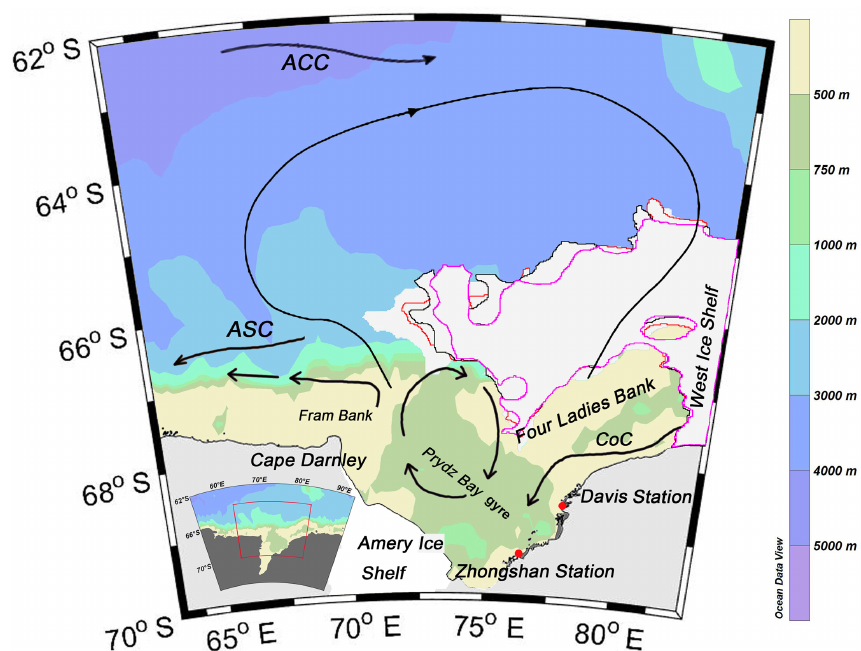
Figure 1. Ocean circulations in Prydz Bay derived from Roden et al. (2013), Sun et al. (2013) and Wu et al. (2017). ASC is the Antarctic Slope Current, CoC is the Antarctic Coastal Current and ACC is the Antarctic Circumpolar Current. During the 4-week cruise, the sea-ice extent varied as indicated by the contoured white areas: the pink line represents week 1 (2–9 February 2015), the black line represents week 2 (10–17 February 2015), the red line represents week 3 (18–25 February 2015) and the unlined white area outside the red contour lines represents week 4 (26 February–5 March